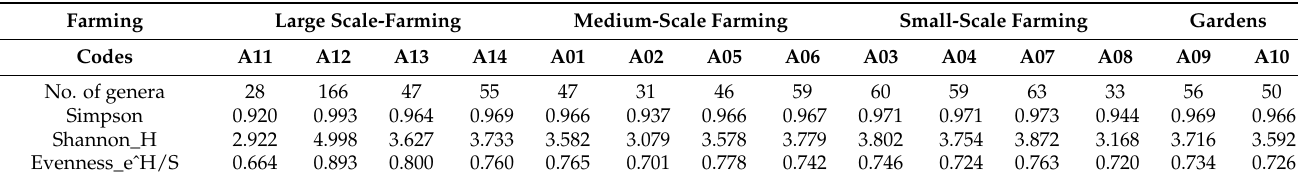
Table 2. Total bacterial diversity indices including endosymbiotic